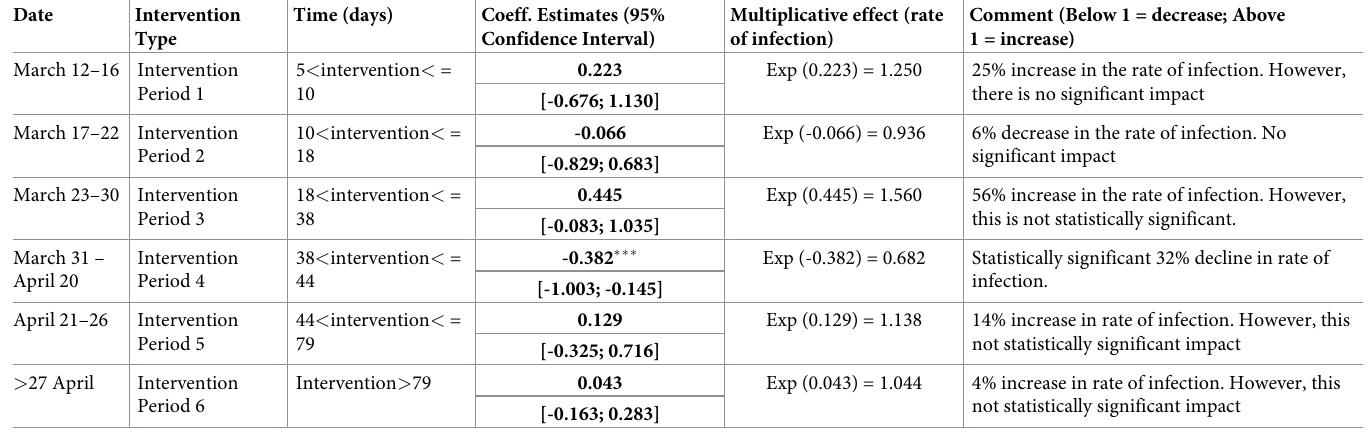
Table 3. Testing for intervention effects. The null hypothesis (H o ) is no intervention effect.